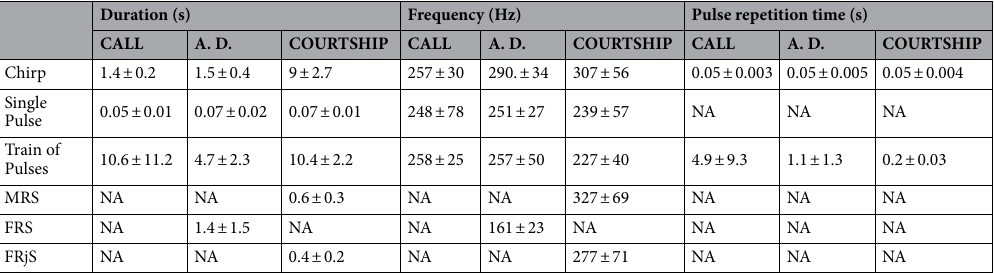
Table 1. Temporal and spectral parameters of GW male signals. Means with standard deviation (SD) are shown. A.D. alternated duet, NA not applicable.